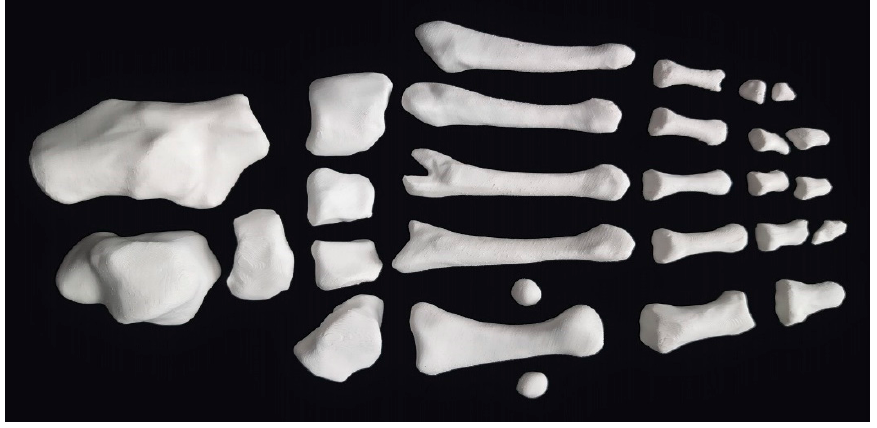
Figure 5. Three-dimensional (3D) printed model of human foot bones.